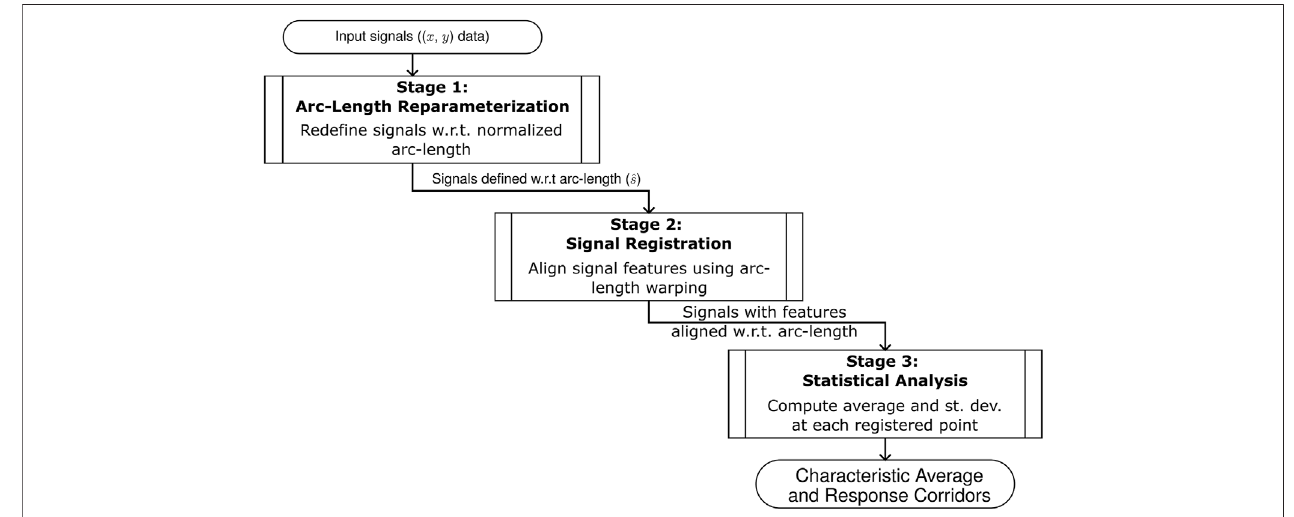
FIGURE1| Anoverviewofthethreestagesofthearc-lengthcorridormethod usedtocomputethecharacteristicaverageandresponsecorridorsofasetofinputs signals.